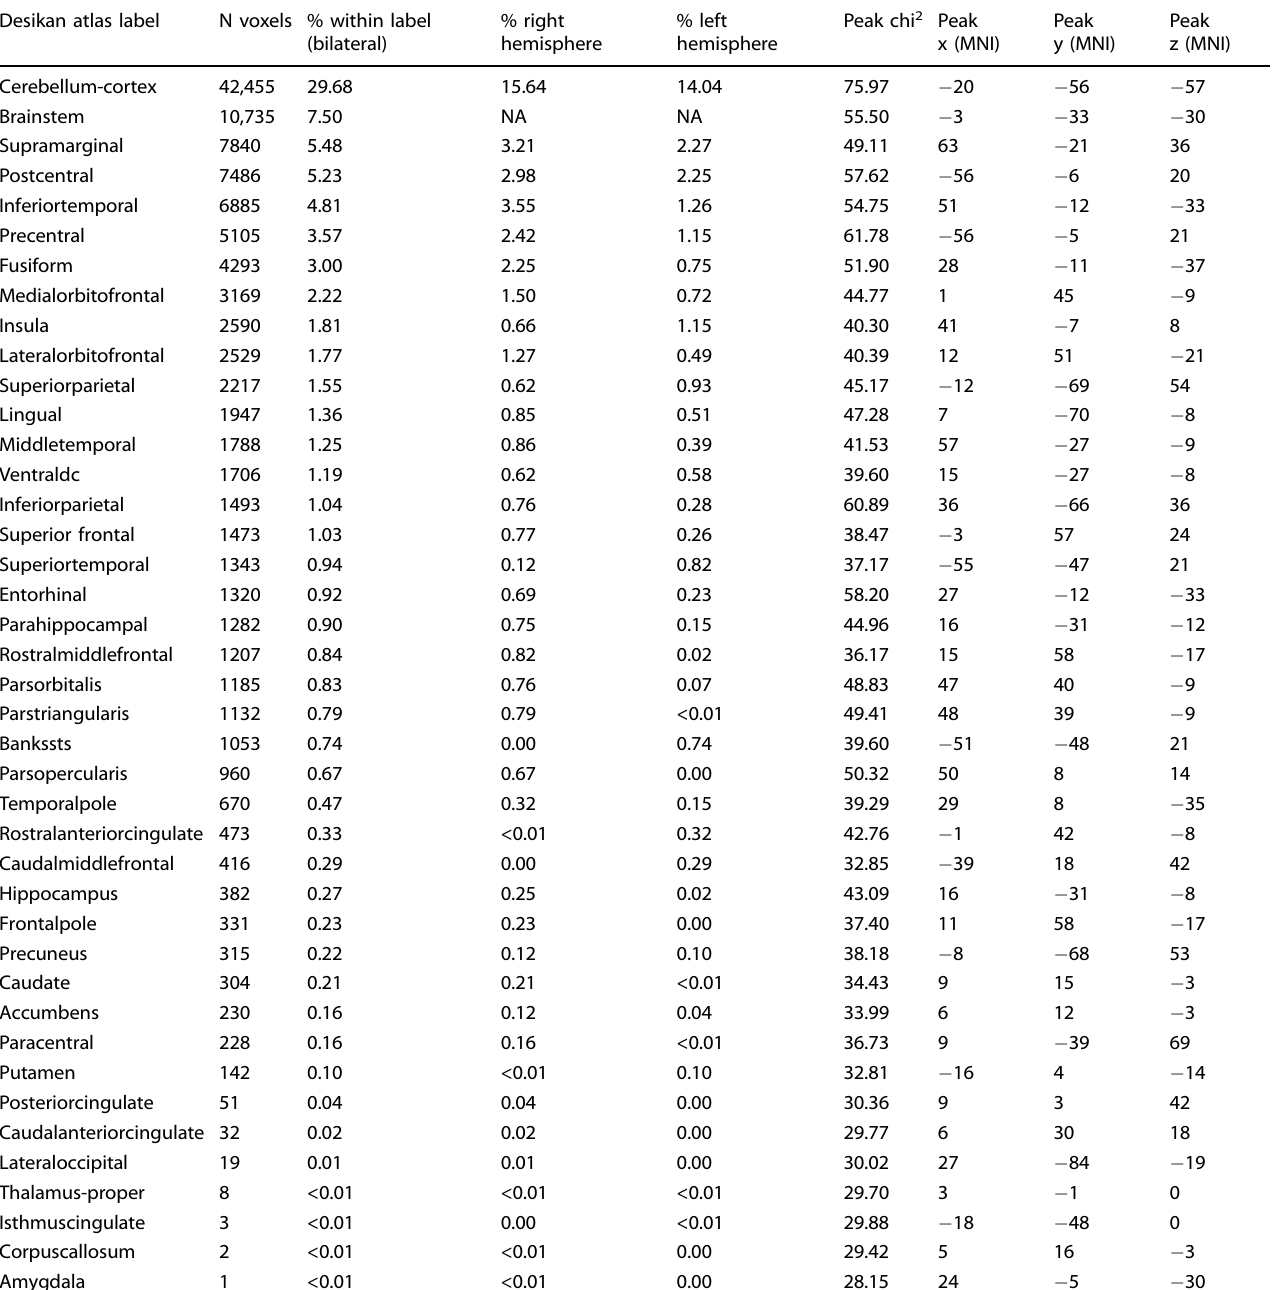
Table 2. Intersection between labels of Desikan atlas and difference map between patients and controls for NNiqr -BOLD synchronization. Desikan atlas label N voxels % within label